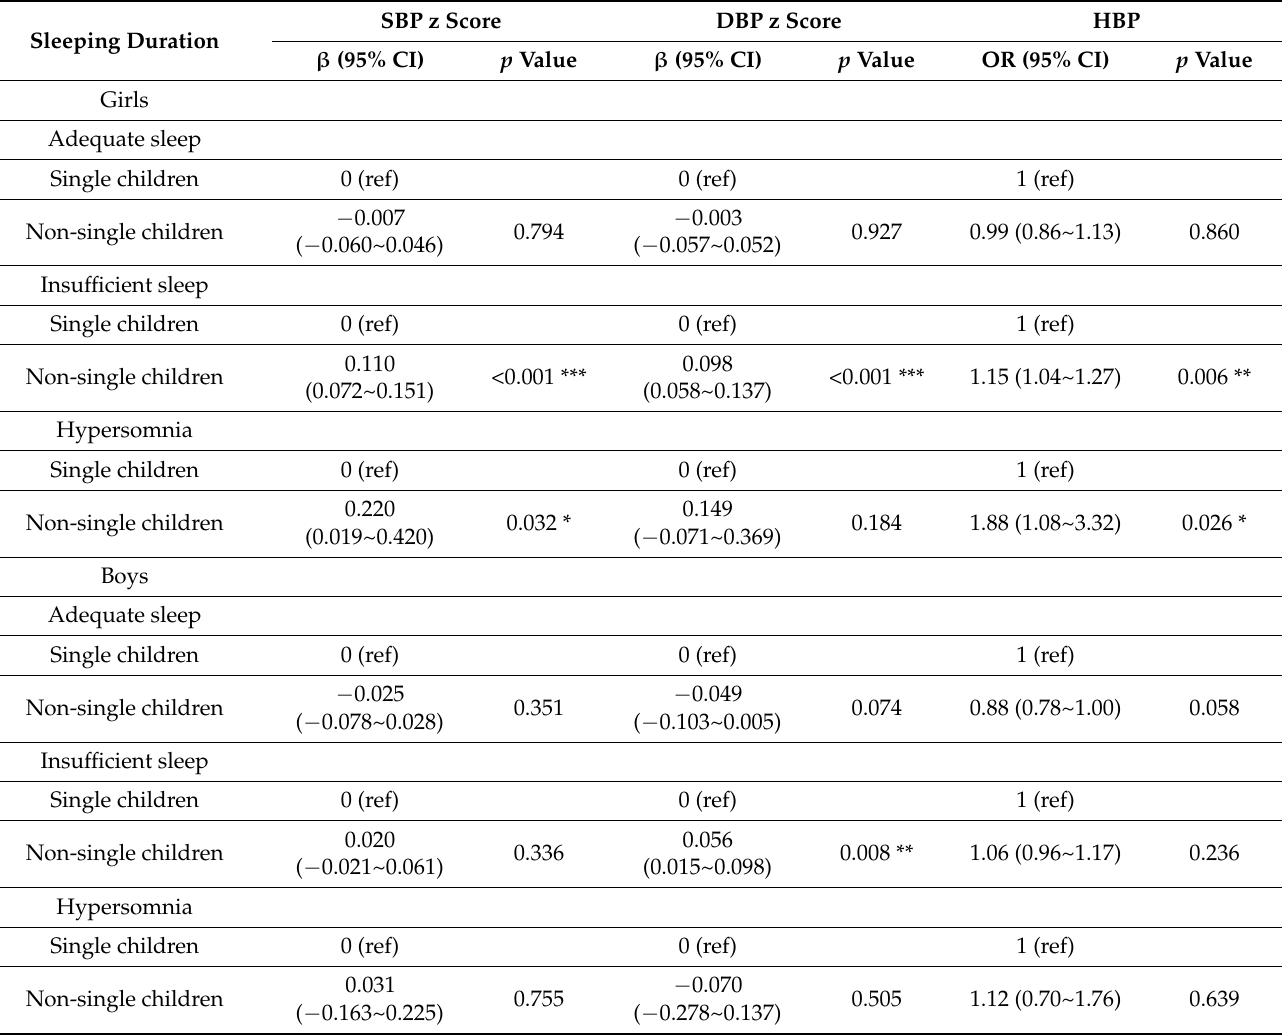
Table 4. Associations between single-child status with childhood BP stratified by sex and sleeping